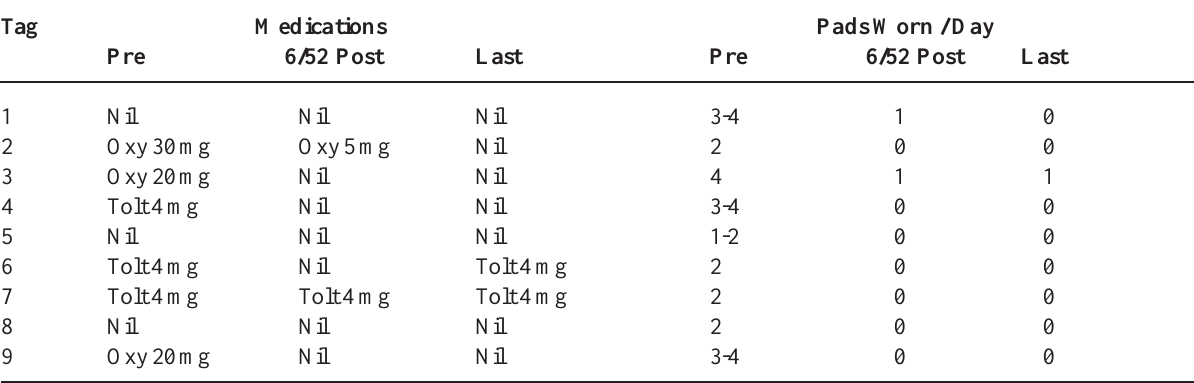
Table 4 – Patient clinical management data pre- and postoperation. Tag